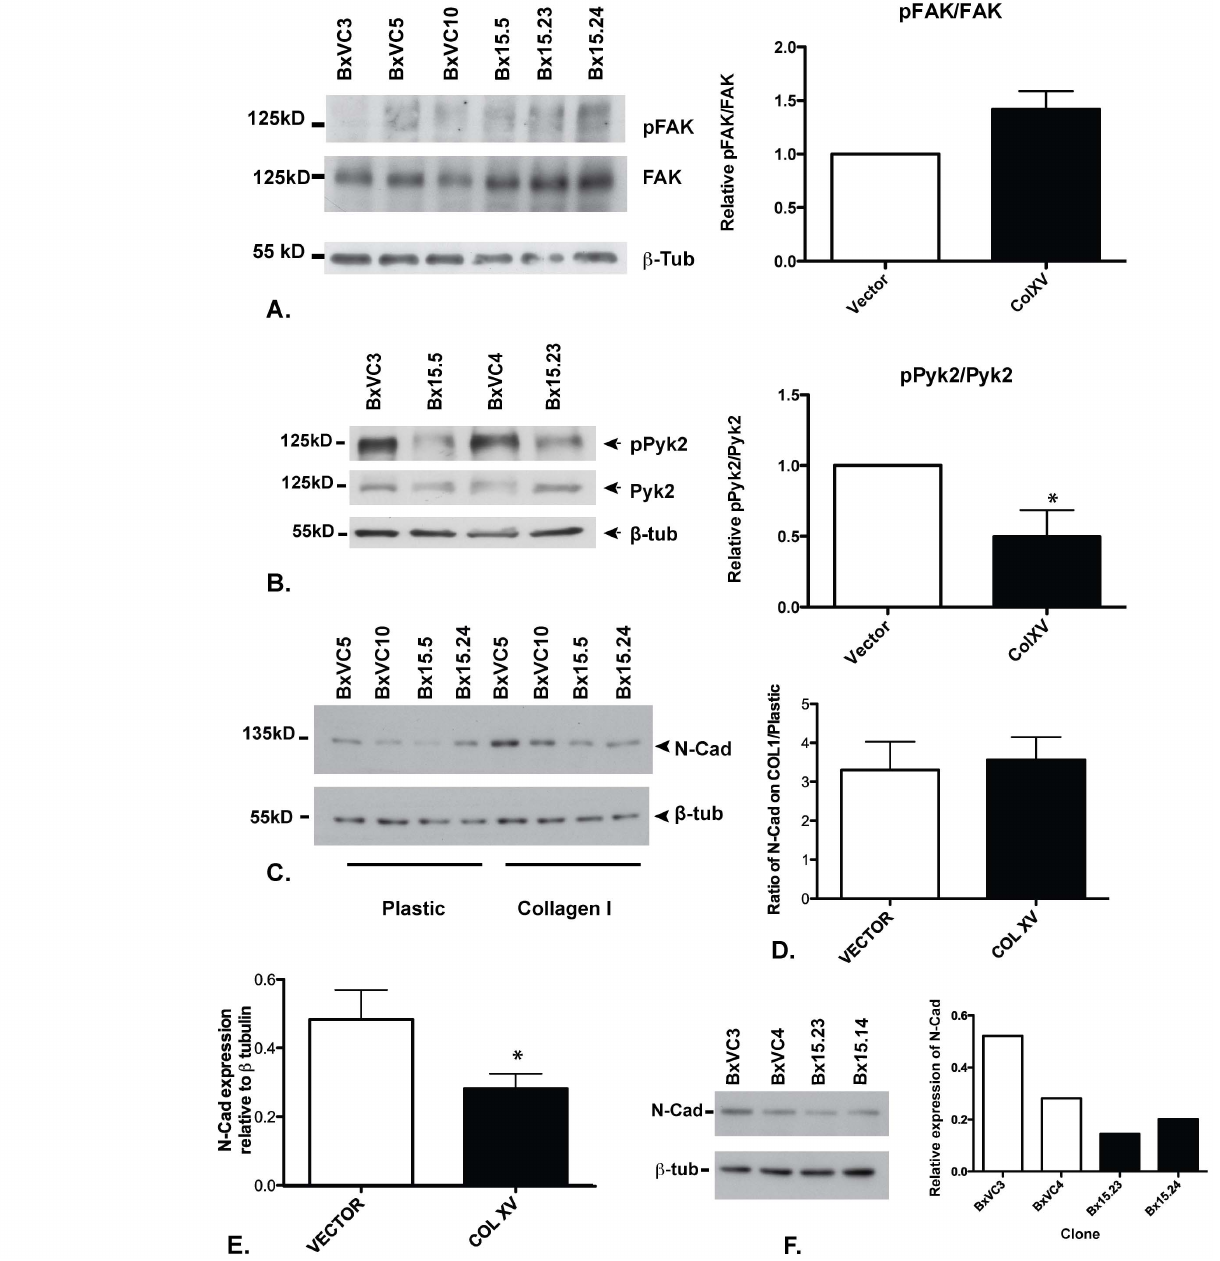
Figure 4. Collagen XV inhibits phosphorylation of Pyk2 and suppresses N-Cadherin. Vector-only (BxVC3, BxVC4, BxVC5, BxVC10) and COLXV-expressing clones (Bx15.5, Bx15.14, Bx15.23, Bx15.24) were grown on COLI coated plates (A, B,); plastic and COLI (C) or plastic alone (F) and lysed after 48 h. Western blots probed with antibodies specific for A) total FAK or pFAK; B) total Pyk2 or pPyk2; C, F) N-Cad; are shown. ß-tubulin provides an estimate of total protein. Expression of COLXV slightly enhances pFAK relative to FAK (though this is not statistically significant, p=0.0913), but depresses pPyk2 relative to Pyk2 (* p=0.0447) and suppresses N-Cadherin levels. Blots were quantified by integrating data acquired with the Lasso tool of Adobe Photoshop (C, D, E, F) and analyzed by students t test (E, *p , 0.01). Each clone was analyzed at least 3 times for FAK, pFAK, Pyk2, pPyk2 and N-Cad expression.